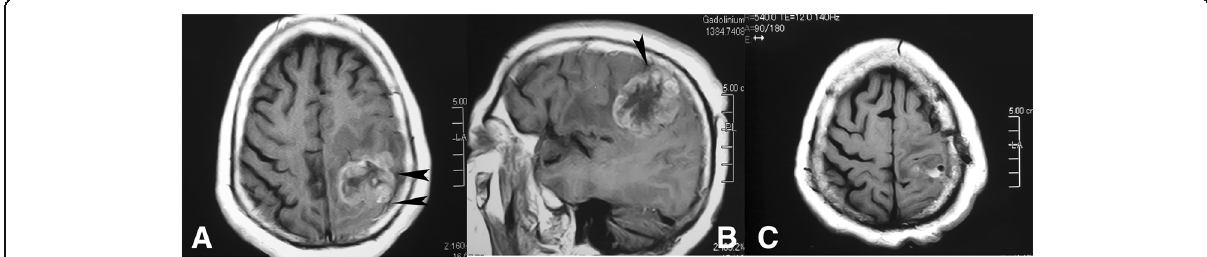
Fig. 2 a Axial and b sagittal post-contrast MRI showing a neoplasm at the motor area. Arrowheads point to the sulcal approach. c Early post- operative axial